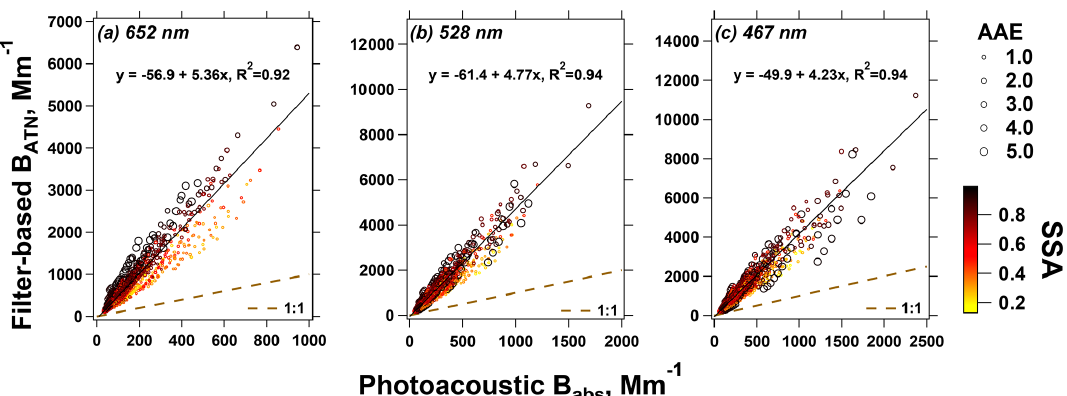
Figure 3. Comparison of the uncorrected CLAP-derived B ATN and the reference B abs at 652, 528, and 467nm for the FIREX data. The data points are colored by the corresponding SSA at the given wavelength. The size of data points reflects their AAE quantified by the two PAXs. The solid line represents the linear regression, while the dashed line is a 1 : 1 line. Table 5. Relationship between the filter-based B abs corrected by Algorithm A and the reference B abs at the operating wavelengths for the filter-based instrument. The relationship is achieved using major axis regression (Ayers, 2001). The value in the parentheses represents the coefficient of determination ( R 2 ) for the linear relationship. 652nm 528nm